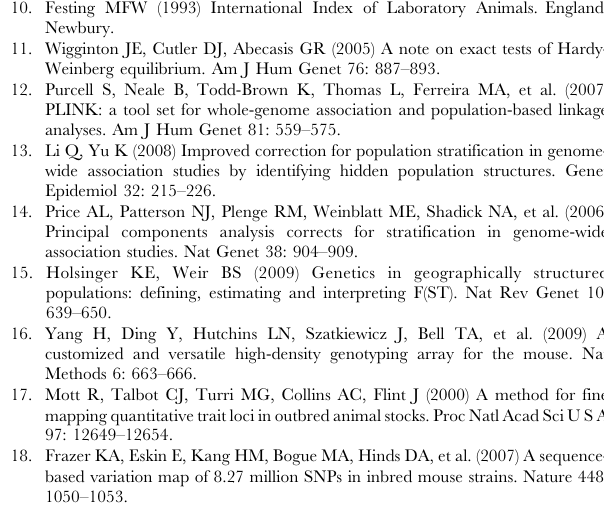
Figure S1 Multi-dimensional scaling of identity by state pairwise distances for all colonies, calculated using PLINK. The figure shows a reduced representation of the results, plotting the position on the first dimension (horizontal axis) against position on the second dimension (vertical axis). Figure S2 PCA and multi-dimensional scaling of identity by state pairwise distances, calculated using PLINK. The figure shows a reduced representation of the results, plotting the position on the first dimension (horizontal axis) against position on the second dimension (vertical axis). Table S1 SNPs used for genotyping the outbred mice